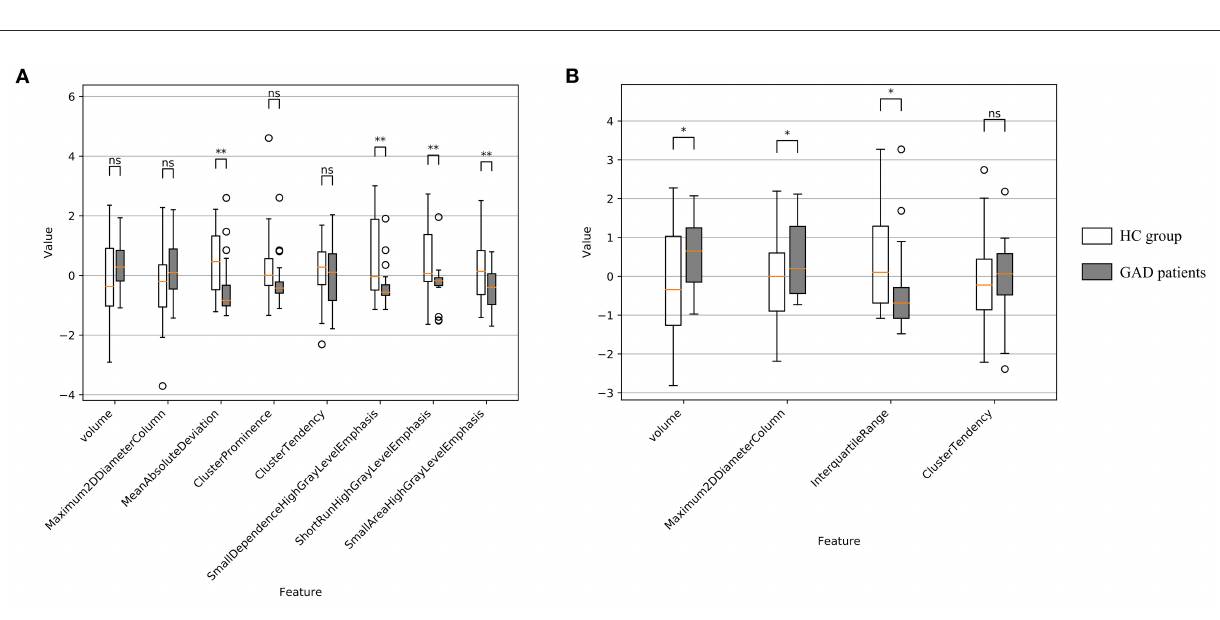
FIGURE5 Feature distribution and group-wise comparison results on selected radiomics features of GAD vs. HC task. (A) Results of left amygdala radiomics features and (B) results of right amygdala radiomics features. Points are outliers in the box plot. ns: not significant; *: p -value ≤ 0.05; **: p -value ≤